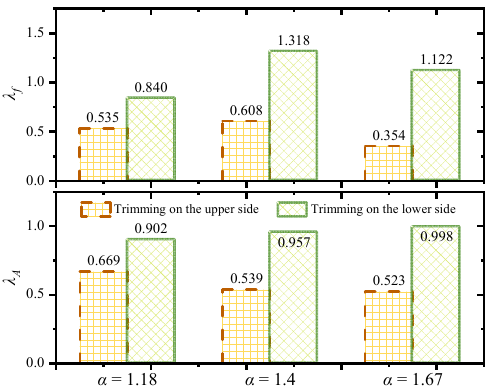
Figure 13. Effectiveness of trimming under different α.